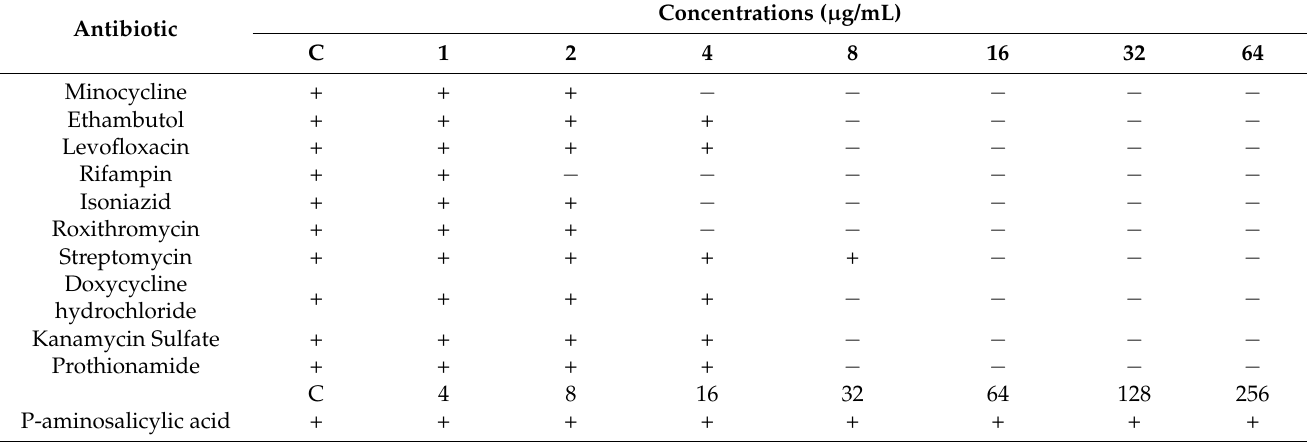
Table 3. Sensitivity of the strain ZHLJ2019 to conventional anti-mycobacterial drugs (+ = bacterial growth; − =growth inhibition).